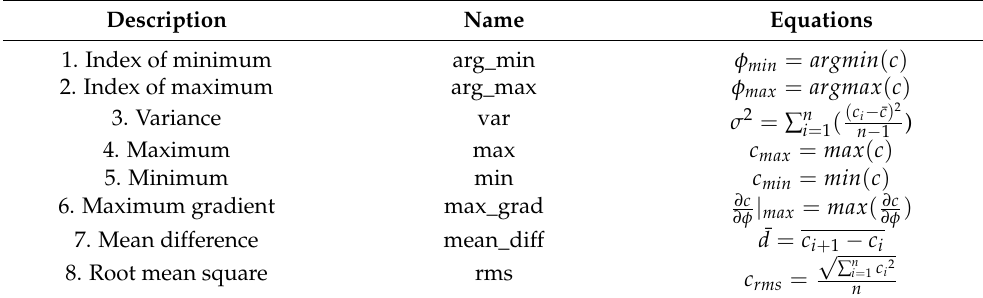
Table 2. Selection of